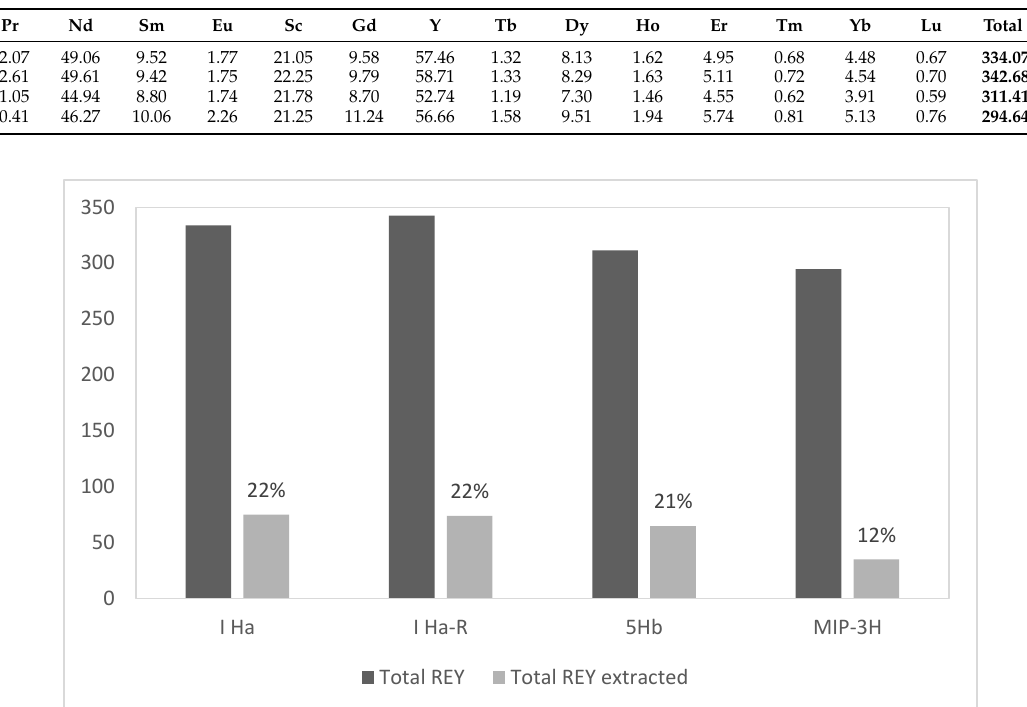
Table 1. The concentration of each rare earth element (including Sc and Y) in whole-rock in ppm.